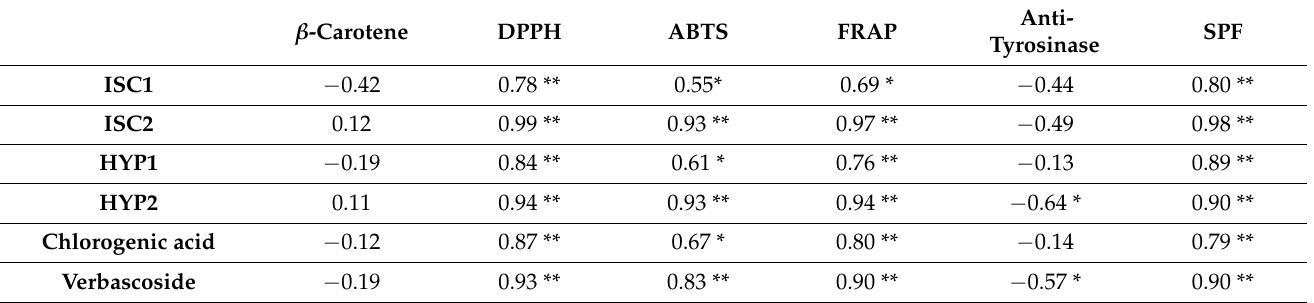
Table 3. Correlation between the content of the target compounds of the tested extract and fractions and biological activity, expressed by the Pearson’s